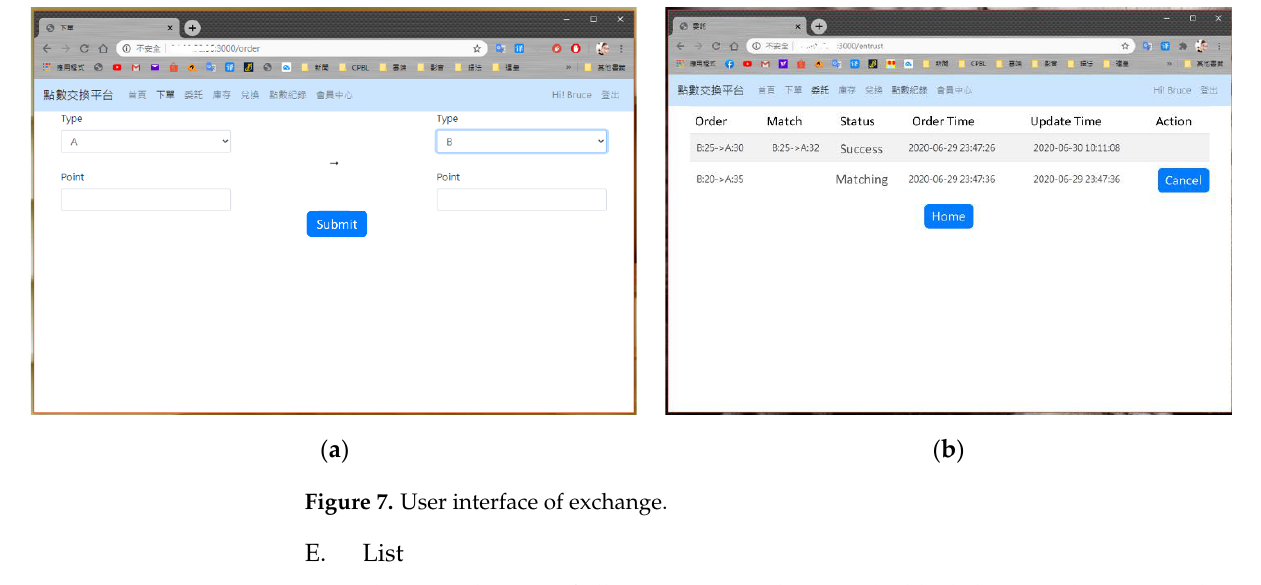
Figure 7. User interface of exchange.